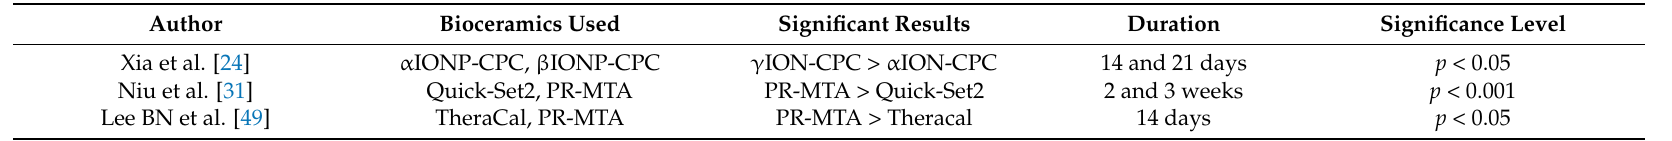
Table 11. Summary of the results of included studies showing significant differences between various bioceramic materials or different concentrations of the same bioceramic material for ARS